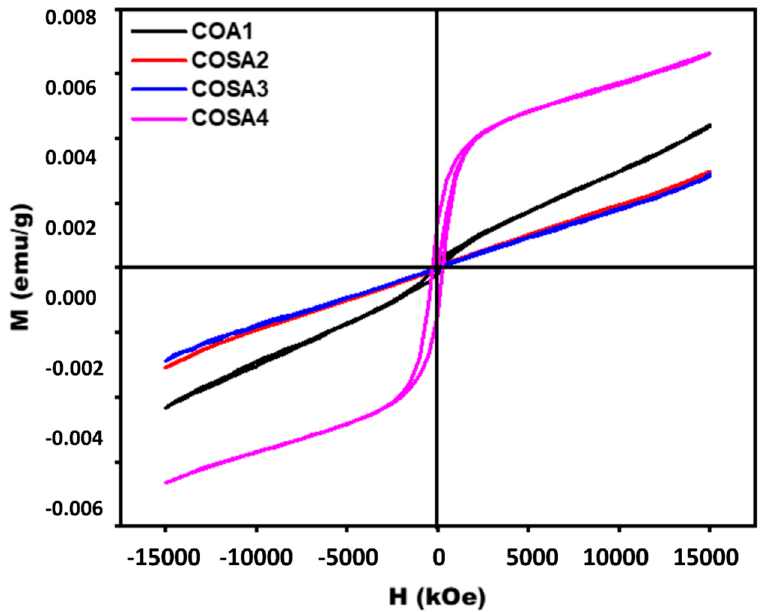
Figure 7. Magnetization curves of Sr doped CoAl 2 O 4 nanoparticles.